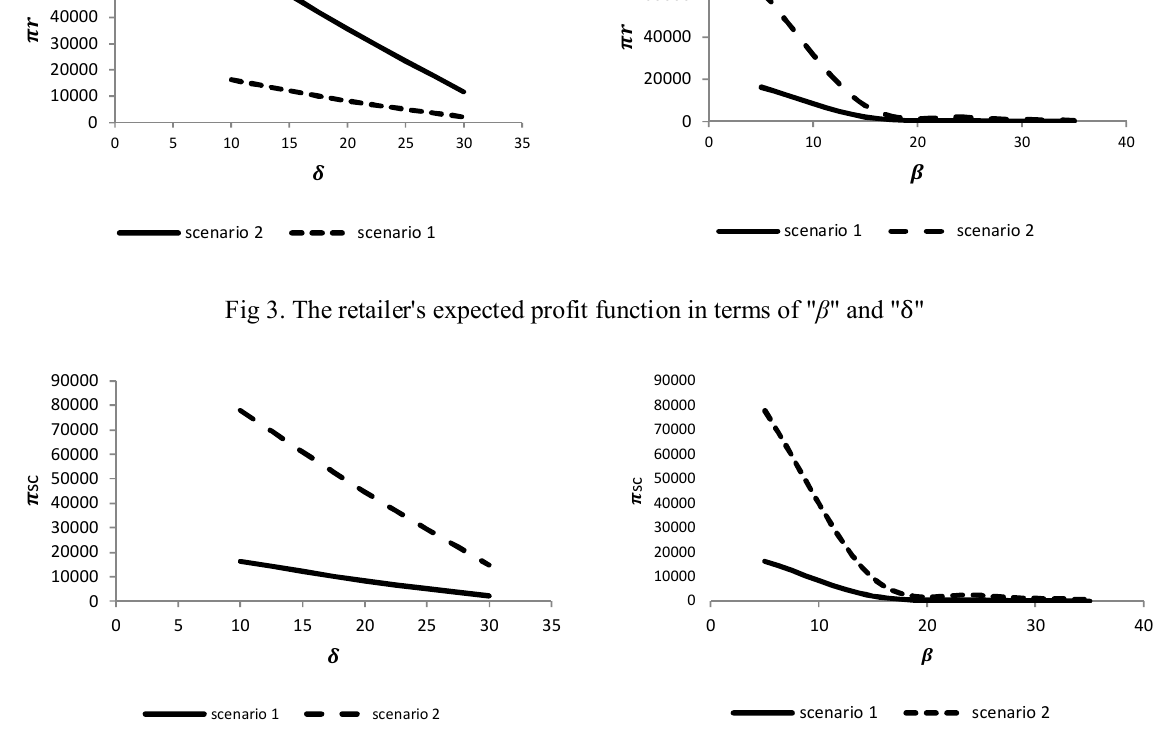
Fig. 4. The expected whole supply chain profit function in terms of β and